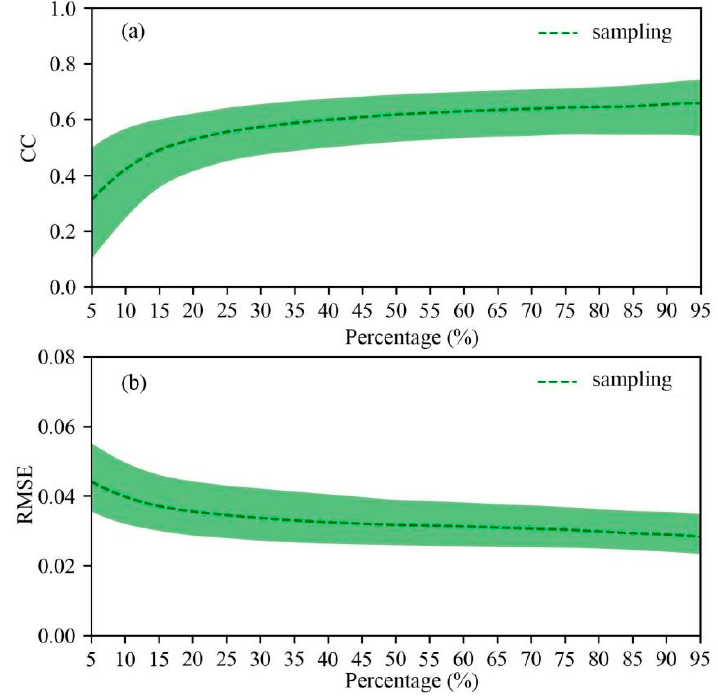
Figure 12. ( a ) The correlation coefficients and ( b ) root mean square errors for the RF gap-filling procedure in the temporal domain under different percentages of data coverage for model training. The dashed lines represent the average results of all grids over China.